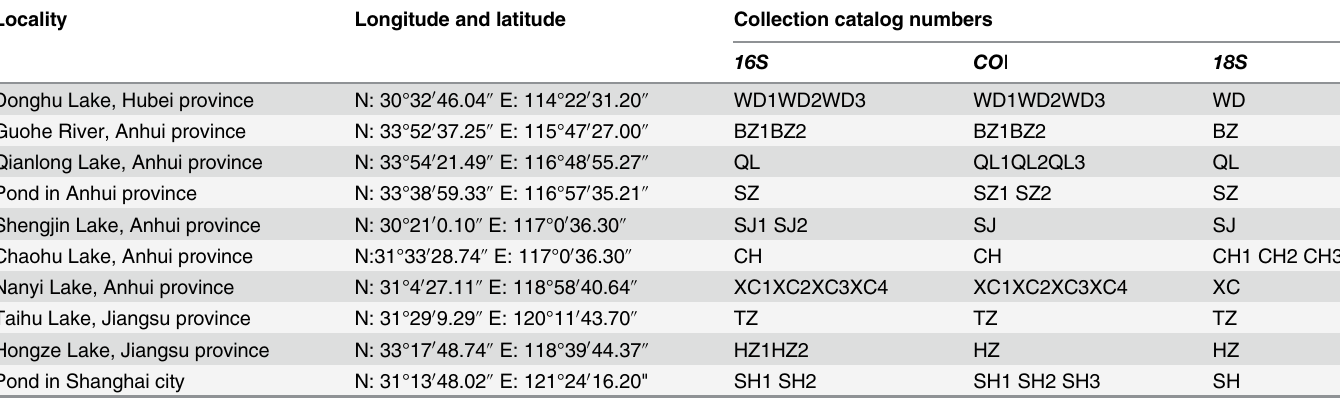
Table 1. Origin and number of D . pulex species in this study.